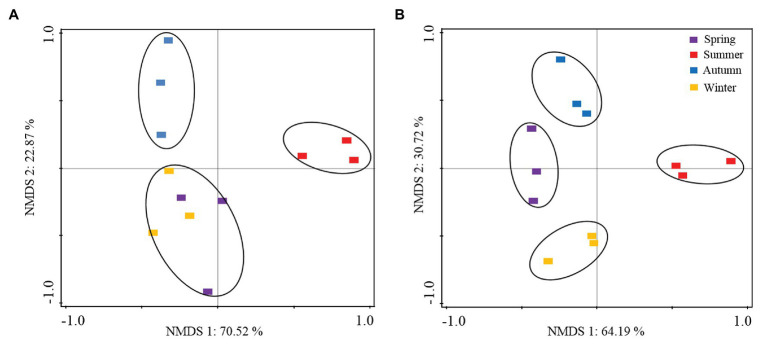
Nonmetric multidimensional scaling (NMDS) plots of the fungal community variation in P. tabuliformis forests based on the relative read abundance of operational taxonomic units (OTUs). (A) Root fungal community; (B) rhizospheric soil fungal community. Samples from seasons are indicated with distinct colors; fungal lifestyles in the community are indicated with distinct symbols.